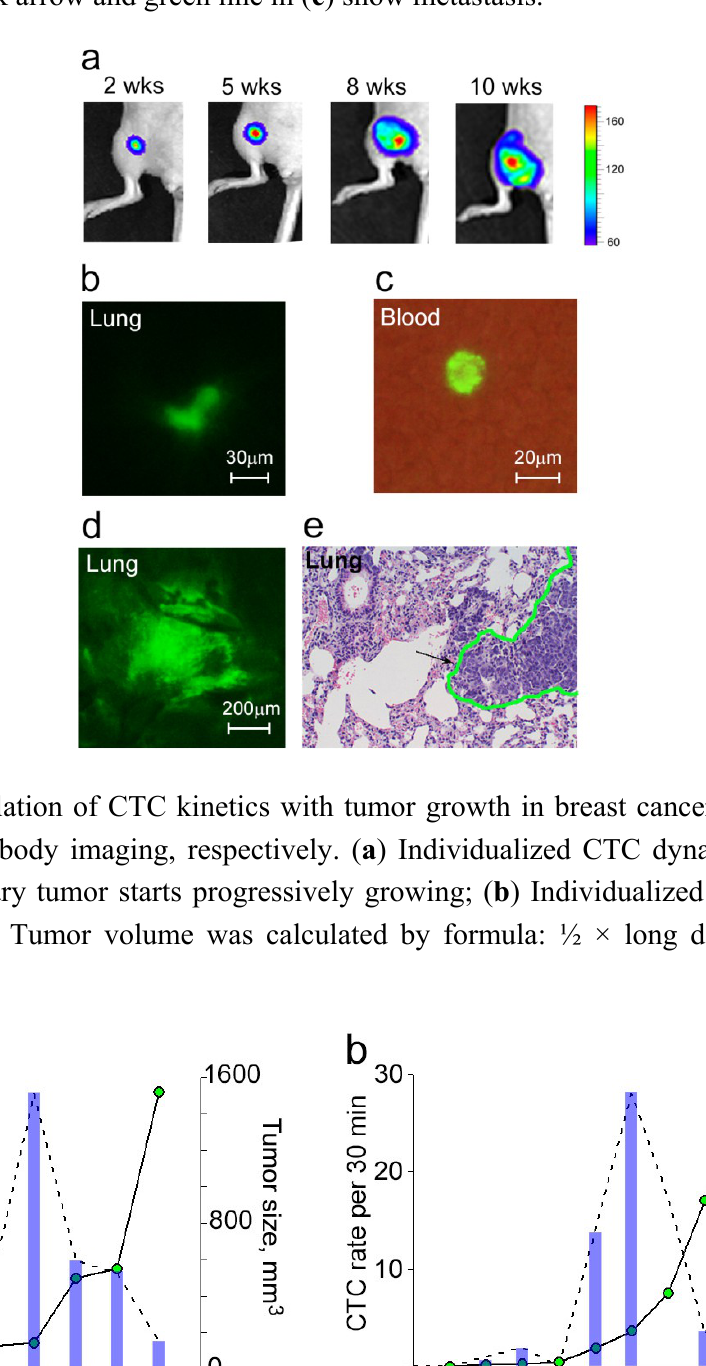
Figure 1. Development of metastatic breast cancer. ( a ) Growth of primary tumor; ( b ) Colony of cancer cells (green) in the lung at week 2 after tumor inoculation; ( c ) A CTC (green) in the blood sample obtained from a mouse at week 1 after tumor inoculation; ( d , e ) Lung metastases at week 8 after tumor inoculation confirmed by two independent methods: fluorescence image of lung ex vivo ( d ) and histological staining (H&E) of a lung section ( e ). Black arrow and green line in ( e ) show metastasis.